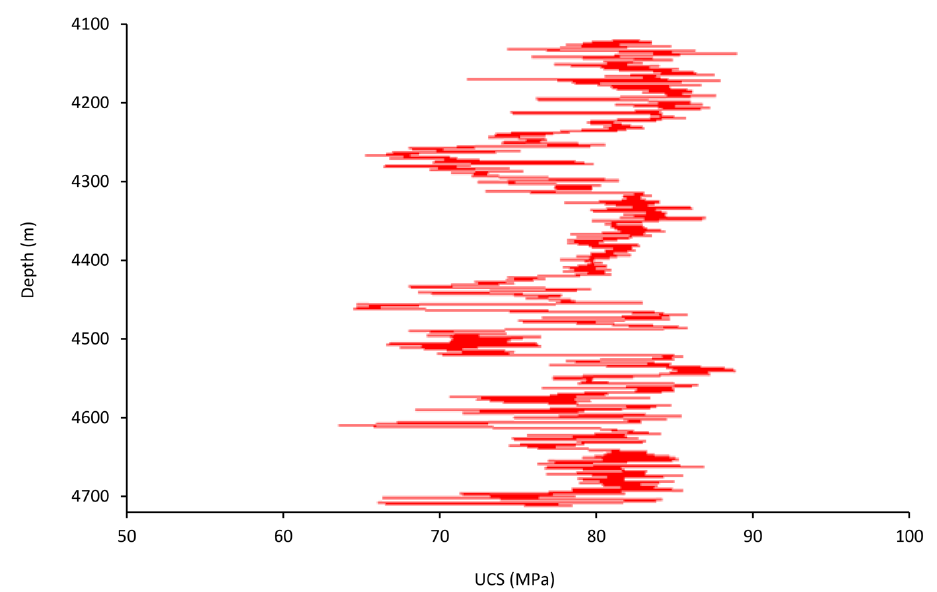
Figure 7. Changes in uniaxial compressive strength (UCS) vs. the depth of wellbore-D in the Azar oilfield.